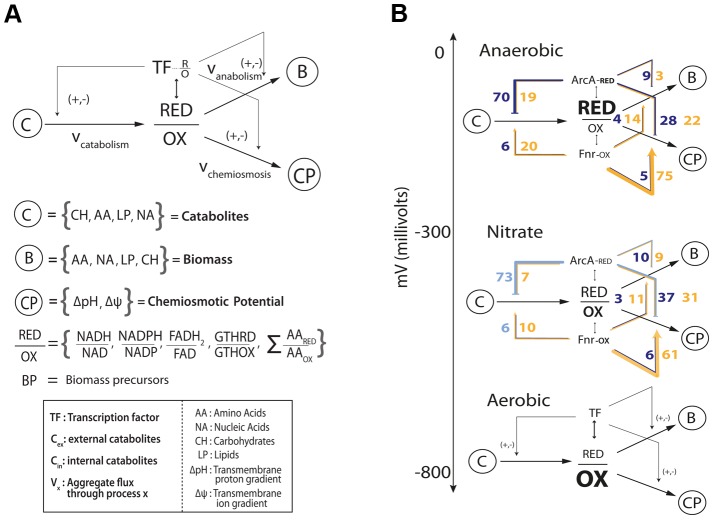
Flow based model of the metabolic-regulatory network explains regulation throughout the anaerobic shift.(A) Considering a mass balance around the ratio of reduced to oxidized molecules allows the unification of catabolism, anabolism, and chemiosmosis into a single process. The ratio of reduced to oxidized molecules is then sensed by ArcA and Fnr to elicit corresponding feedforward and feedback regulatory circuitry which allows the cell to maintain this critical ratio. (B) Mapping of the regulation of gene products (Figure 3) for each branch of the circuit reveals a broad trend of feedforward with feedback-trim regulation. Under fermentative conditions the redox ratio is high and the observed regulation works to lower the input and activate the output to bring the ratio down. Under nitrate respiration, the ratio drops and the circuit maintains a similar number of connections but is shown to decrease in gross activity levels.